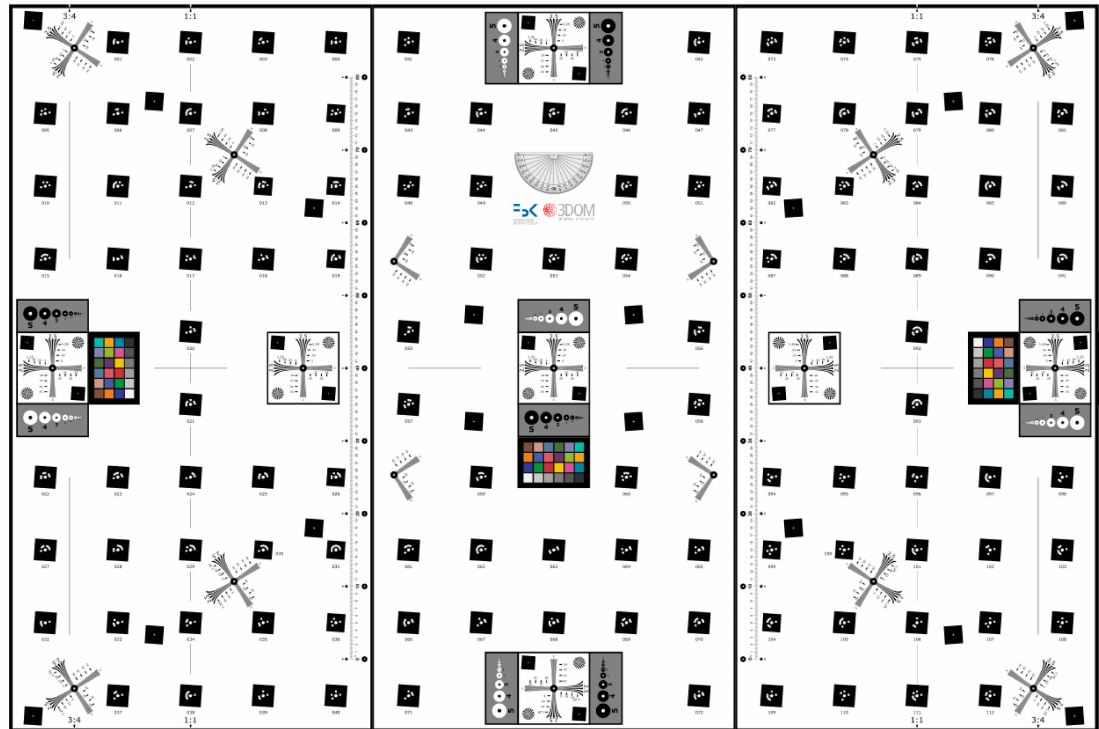
Figure 17. The newly designed modular test-field for resolution and DOF measurements as well as camera calibration. The test-field, being modular, can be mounted to accommodate different heights of the